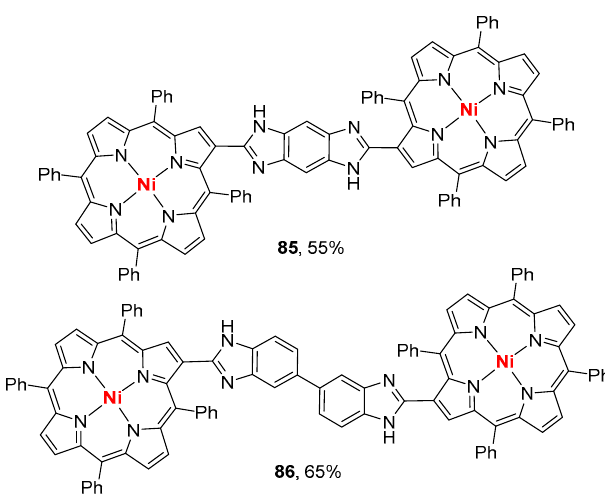
Figure 16. Dyads obtained from reaction of β -CHOTPP with benzene-1,2,4,5-tetraamine tetrahydrochloride and 3,3 ′ -diminobenzidine